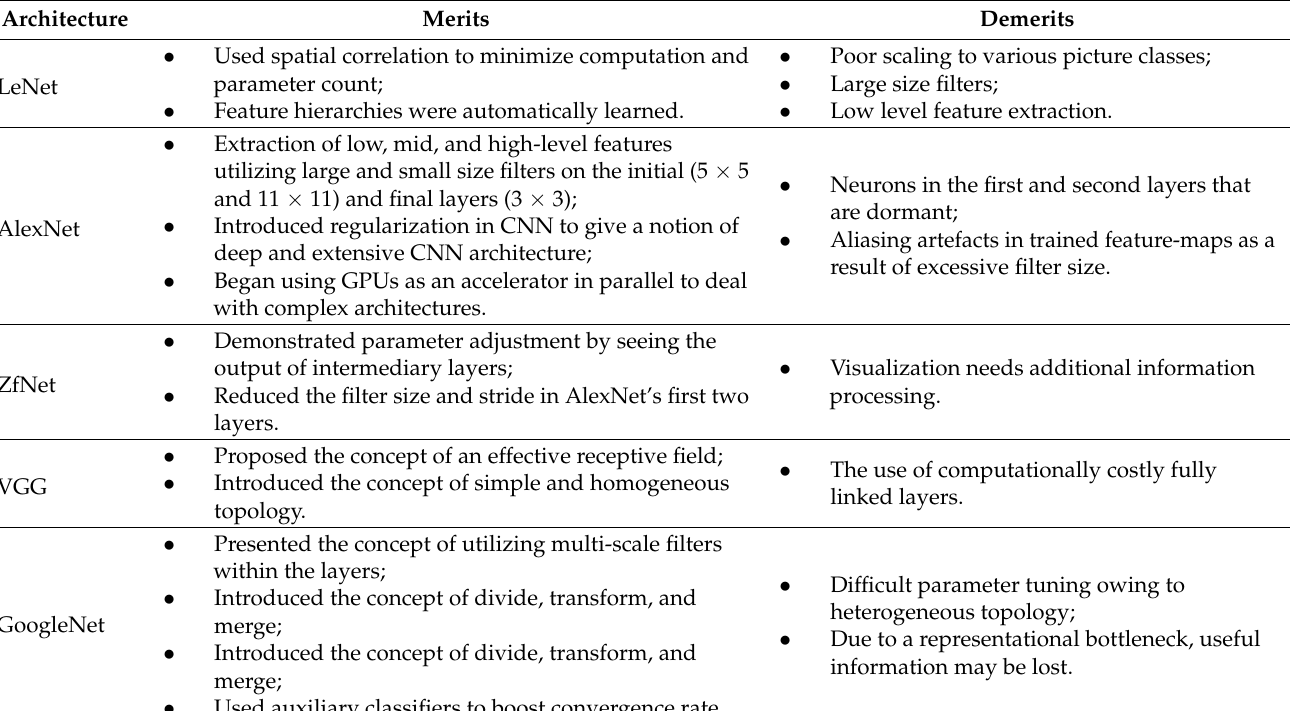
Table 2. Major issues linked with the deployment of CNN architectures based on spatial exploitation.